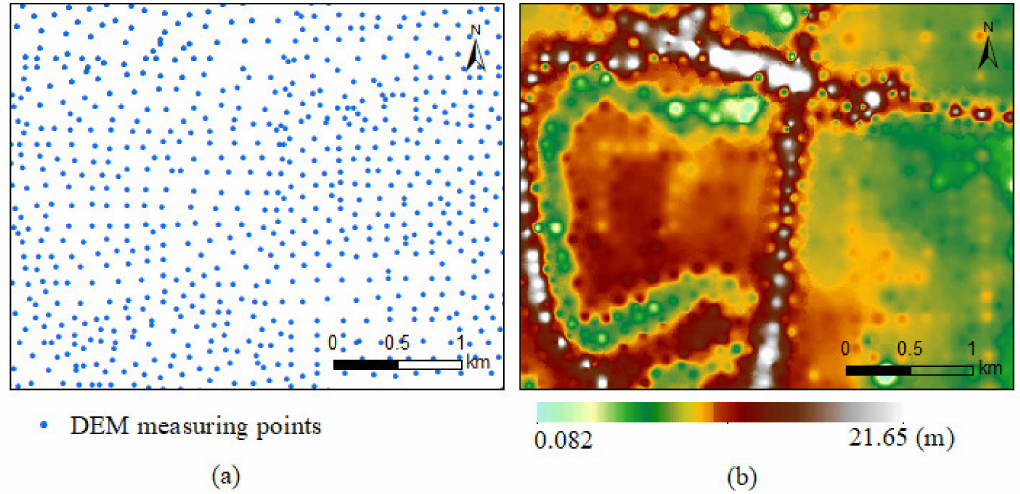
Figure 2. DEM measuring points ( a ) and DEM with 10-m spatial resolution ( b